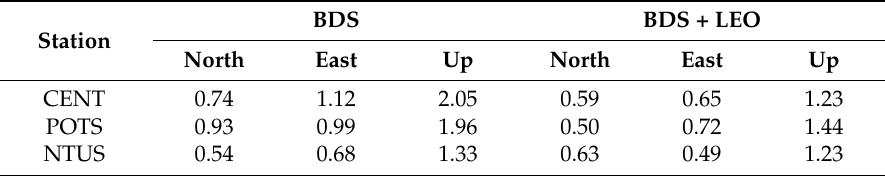
Table 8. PPP precision of both BDS and BDS + LEO after the ambiguity convergence (cm). Station